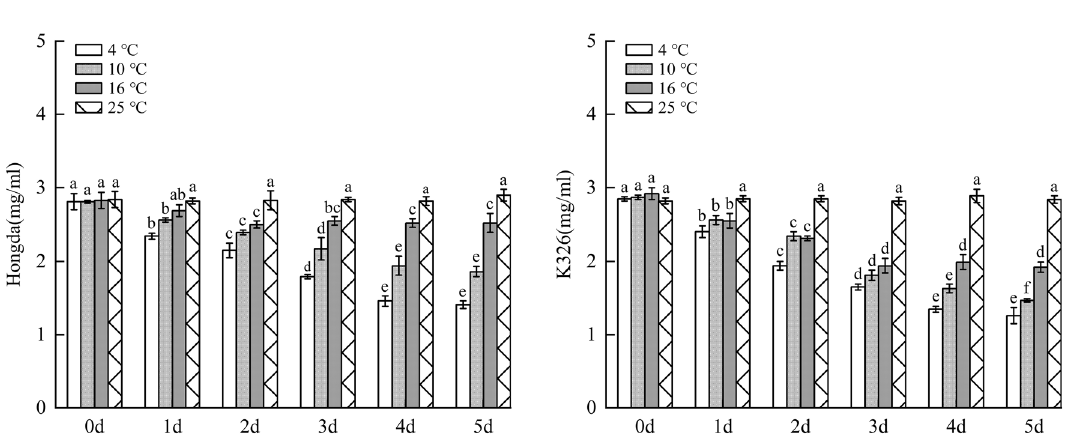
Figure 8. The changes of chlorophyll b content under different low-temperature stresses. Different lowercase letters indicated that there were significant differences at different times under the same temperature treatment (P < 0.05). The values were the mean of three biological replicates.